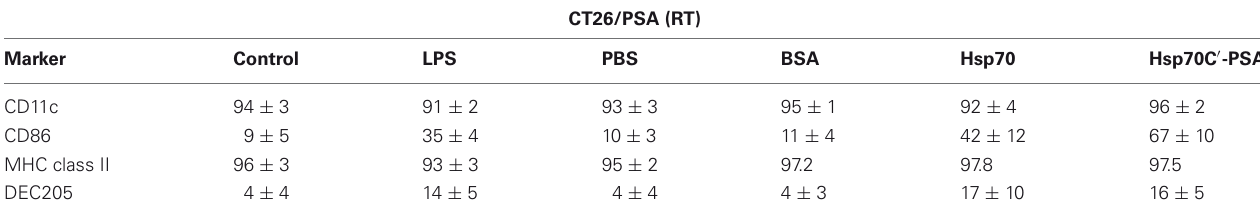
Table 1 | DC surface marker expression after incubation with irradiated CT26/PSA cells in the presence or absence of Hsp70 or Hsp70C (cid:2) -PSA a